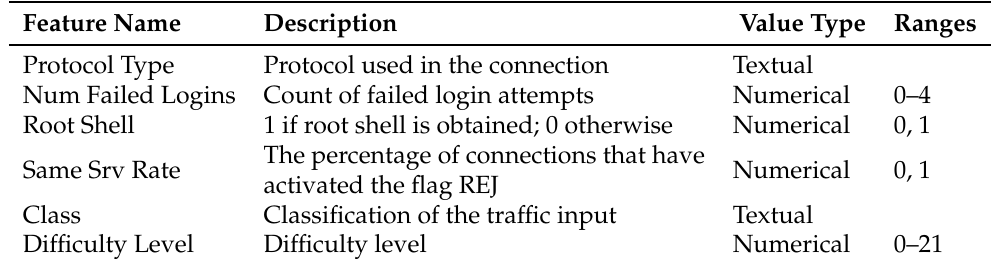
Table 1. Description of some